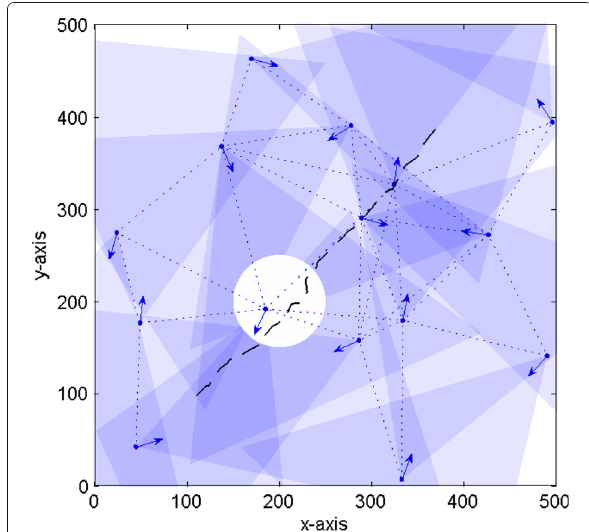
Fig. 8 One realization of a sensor network together with the target trajectory (black dashed line). The target is occulted when crossing the white circle